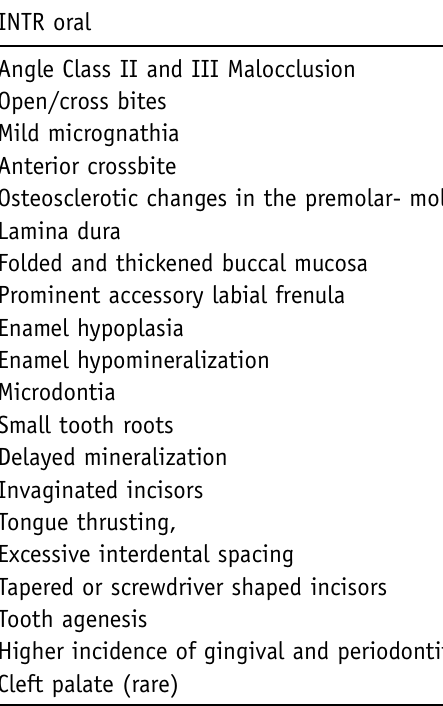
Table II. Orofacial features of Williams – Beuren